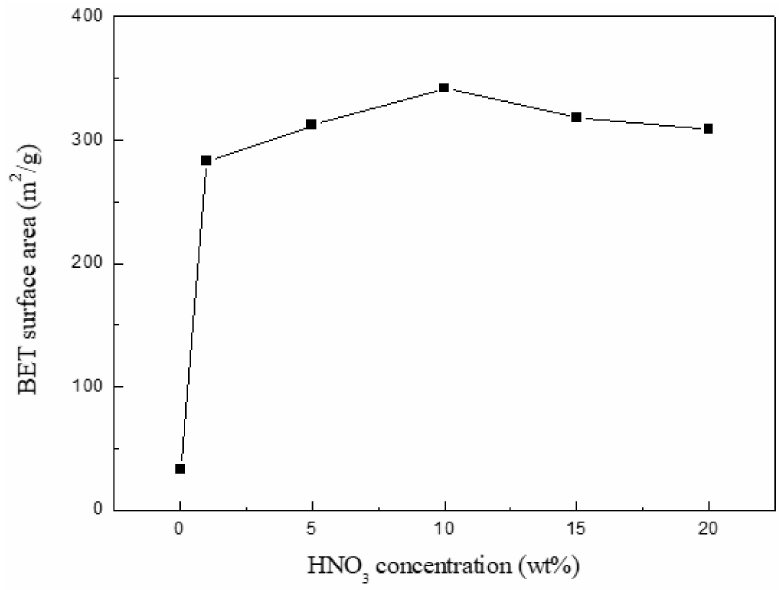
Figure 1. BET surface area of chitin-char treated by HNO 3 of different